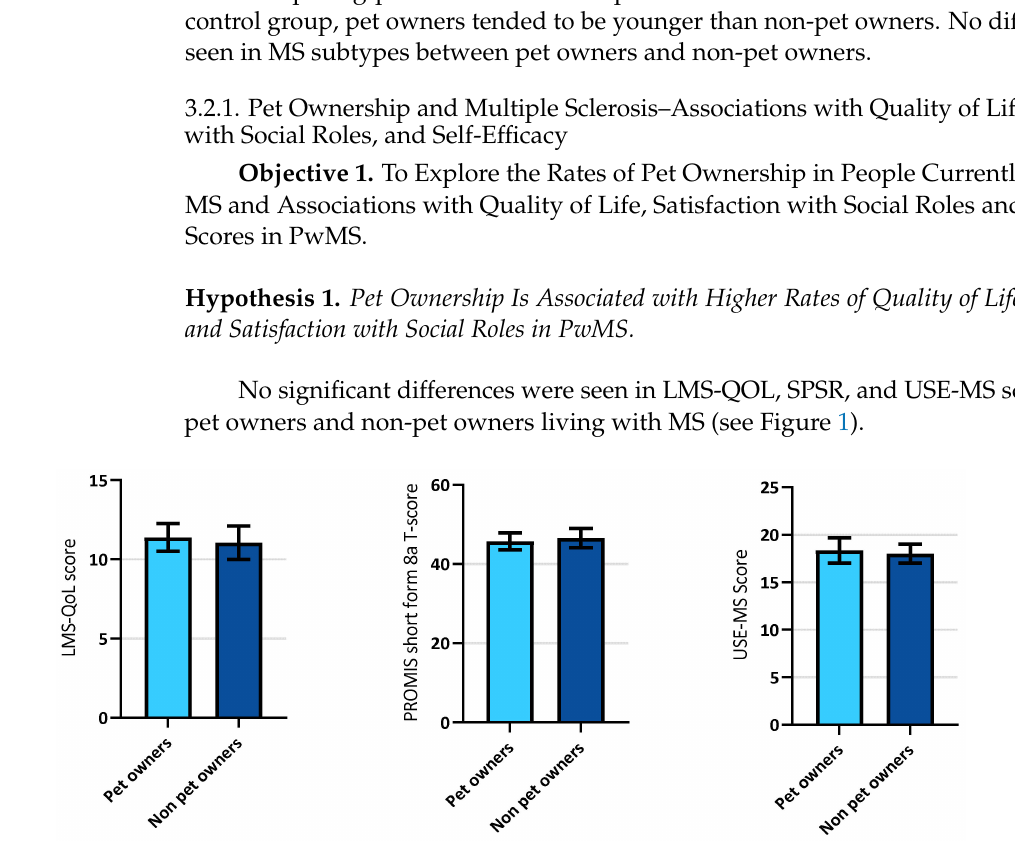
Figure 1. Comparisons of PwMS with and without pets; data displayed as mean +/ − 95% confidence intervals. ( A ) Com- pares Leeds MS-QOL scores between pet owners ( n = 109; mean 11.38; 95% CI 10.5–12.25) and non-pet owners ( n = 78; mean 11.05; 95% CI 9.99–12.11). ( B ) Compares PROMIS short-form 8a scores (assessing satisfaction with social roles) between pet owners ( n = 106; mean = 45.72; 95% CI 43.62–47.81) and non-pet owners ( n = 78; mean = 46.58; 95% CI 44.12–49.04). ( C ) Compares USE-MS scores between pet owners ( n = 109; mean = 18.35; 95% CI 17.00–19.69) and non-pet owners ( n = 79; mean = 18.15; 95% CI